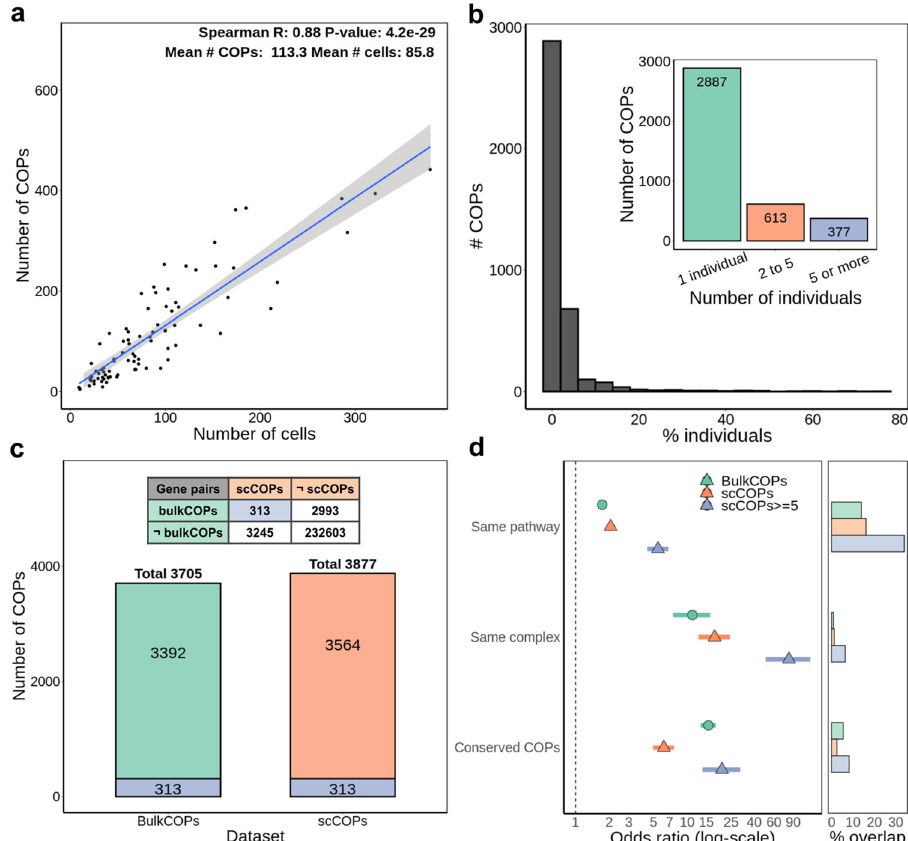
Fig. 2 Features of single-cell local gene co-expression. a Number of cells per individual and number of COPs mapped. Fit line corresponds to a linear regression model with 95% con fi dence intervals; b distribution of the percentage of individuals in which COPs are present. The inner plot counts how many COPs in 1, 2 to 5 (exclusive) and 5 or more individuals; c total number of COPs detected with bulk data (bulkCOPs) and single-cell data (scCOPs, union across individuals). Numbers in green represent COPs found from both bulk and single-cell data. The contingency table summarises the overlap between scCOPs and bulkCOPs considering the common background of gene pairs tested, which differs slightly between both datasets due to different genes being expressed and detected; d one-sided Fisher ’ s exact test odds ratio enrichment (and 95% con fi dence interval) for the pair of genes in COPs to belong to the same gene pathway, protein complex or in the set of COPs conserved across GTEx tissues. “ scCOPs > = 5 ” are a subset of COPs that are found across 5 or more individuals. x -axis is log-scaled, but values shown are before transformation. The right part of the plot denotes the percentage of COPs in each functional